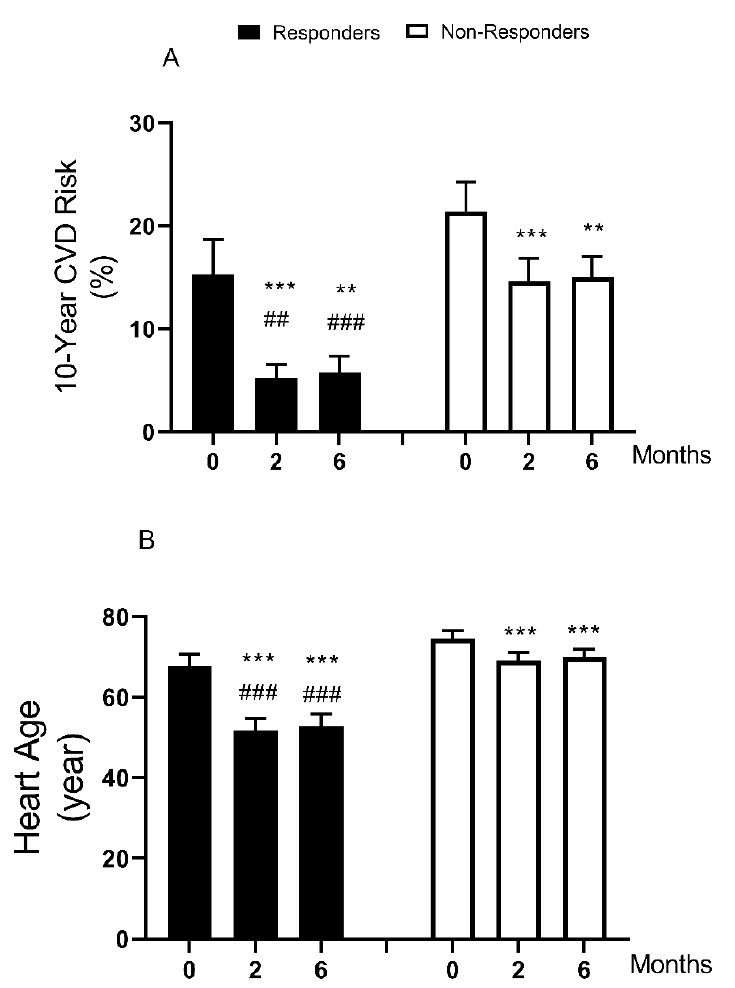
Figure 1. Change in cardiovascular disease (CVD) risk and heart age after weight loss and remission of type 2 diabetes. Data were presented as mean ± SEM. A: 10-year CVD Risk, B: Heart Age. There were 29 participants (12 responders/17 non-responders) and they were studied at baseline, 2, and 6 months post-weight loss. ** p < 0.01, *** p < 0.001 (vs. 0 month). ## p < 0.01, ### p < 0.001 (vs.